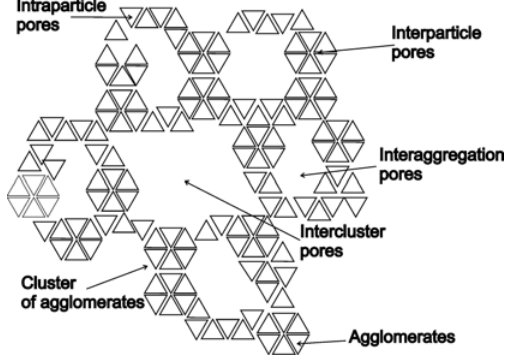
Fig. 1 Structural elements and pore types (modified from Kaneko [8]).